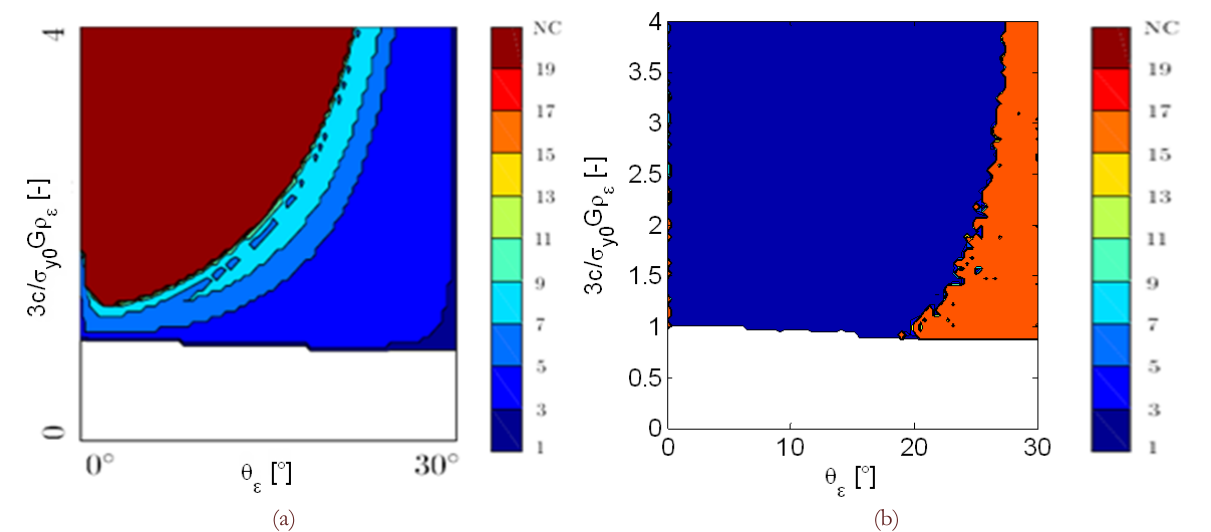
Figure 1: Single increment test. Number of iterations needed for convergence for Von Mises–Tresca yield surface ( m =20) by: (a) return mapping algorithm [17]; (b) proposed incremental energy minimization algorithm.